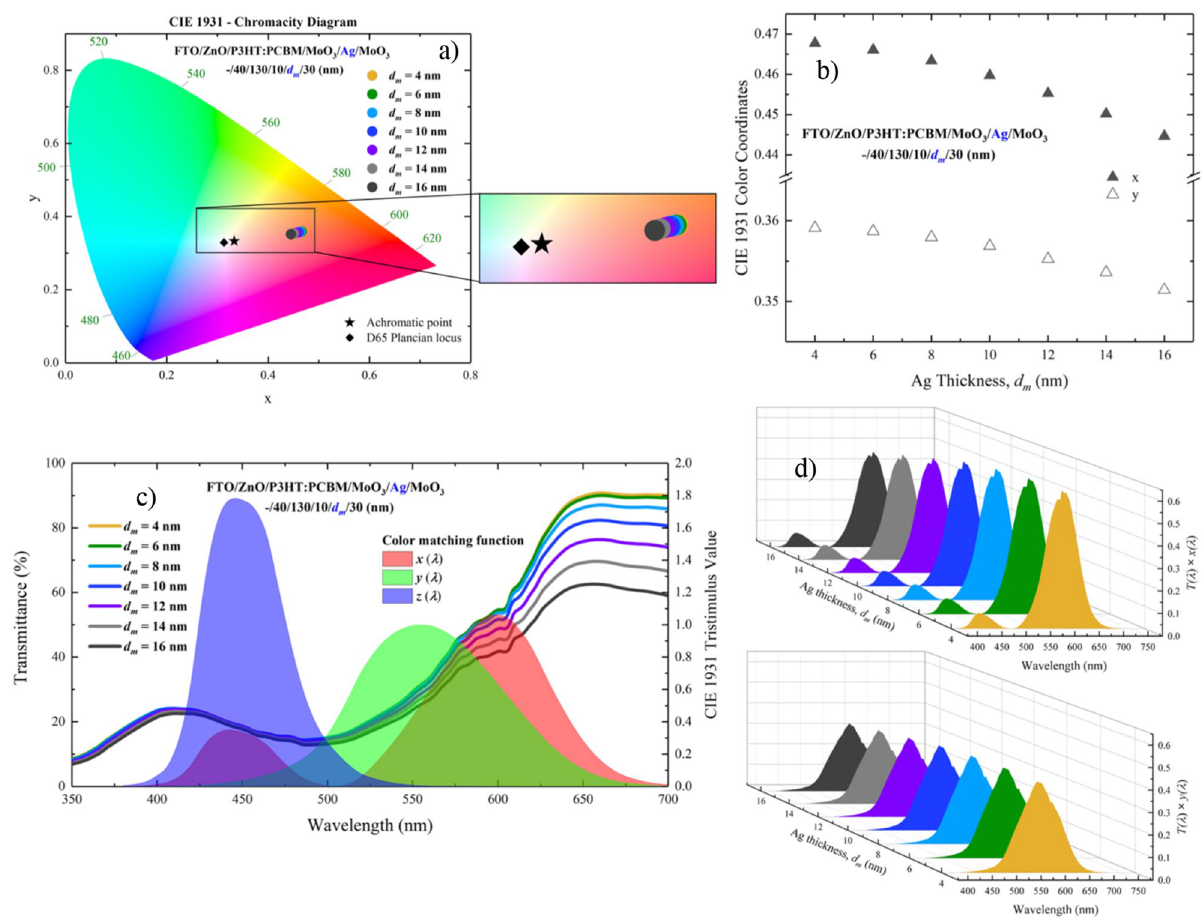
Figure 9. Calculations for FTO/ZnO/P3HT:PCBM/MoO 3 /Ag/MoO 3 (–/40/130/10/ d m /10 nm) ST-OSC with different d m ; ( a ) the location of the color coordinates in the CIE 1931 chromaticity diagram, ( b ) the change of color coordinates, ( c ) the intersection of the transmittance characteristic of the ST-OSC with the color matching functions, and ( d ) the change of T ( (cid:31) )